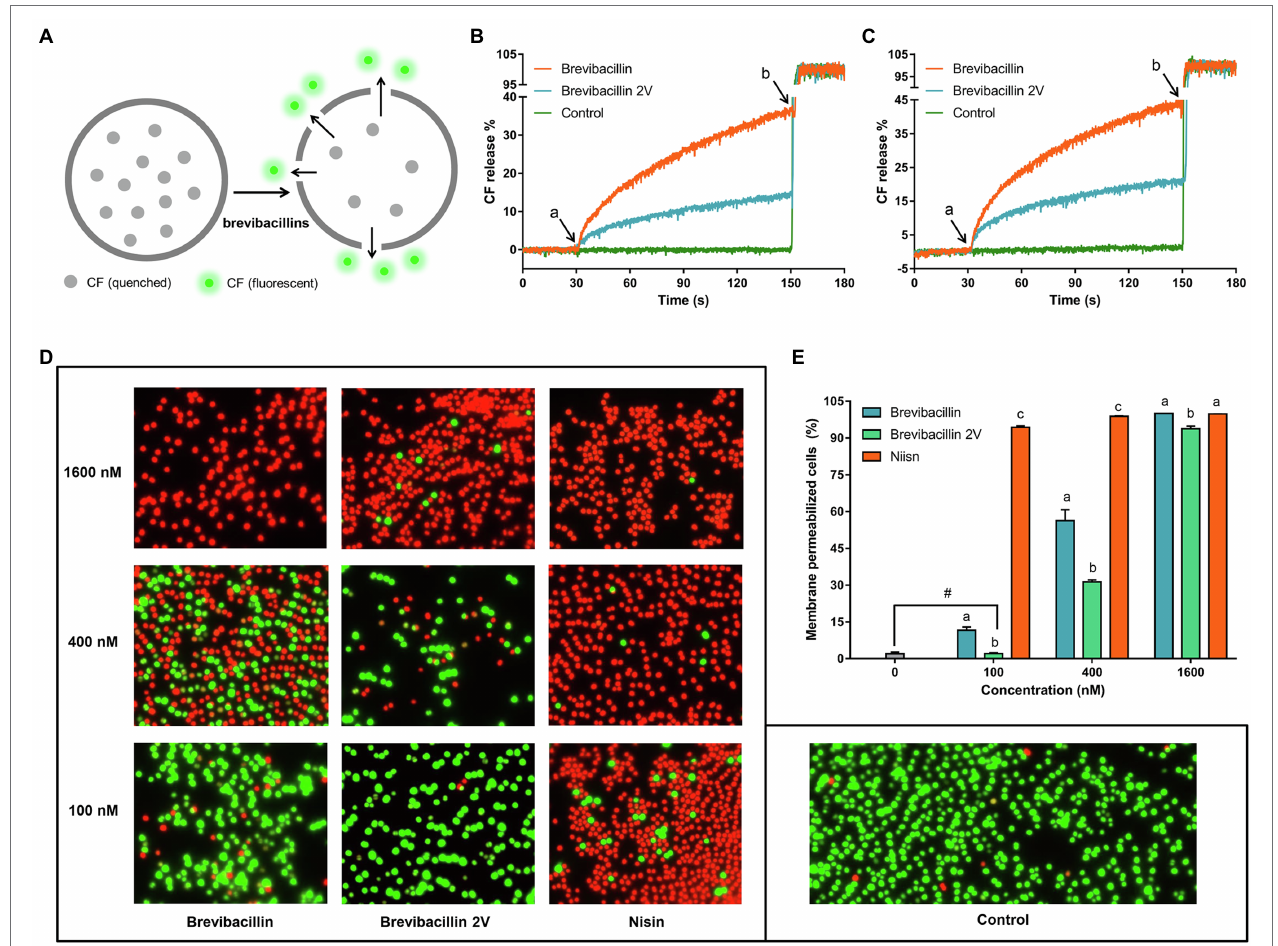
FIGURE 7 | Brevibacillins disrupt membrane permeability without the need for Lipid II binding. (A) , Cartoon schematic of the assay used to assess membrane permeability disruption of brevibacillins. (B) , CF releases (%) vs. time graph showing the effects of adding brevibacillins to DOPC-LUVs with 0.1% Lipid II; peptide concentrations were 100 nm; a, when peptides were added; and b, when 20% Triton X-100 added. (C) , CF releases (%) vs. time graph showing the effects of adding brevibacillins to LUVs of pure DOPC; peptide concentrations were 100 nm; a, when peptides were added; and b, when 20% Triton X-100 was added. (D) , fluorescence microscopic images of S. aureus (MRSA) after have been treated by a series concentrations of brevibacillins and nisin for 15 min. (E) , the ratio of membrane permeabilized cells that was quantified by Adobe Photoshop 2021; the data are representative of three independent experiments. Significant differences were considered at p < 0.05; a,b,c bars at the same concentration without the same superscripts differ significantly ( p < 0.05); and # brevibacillin 2V did not induce membrane permeabilization at a concentration of 100 nm, which showed no significant difference on the ratio of membrane permeabilized cells with untreated